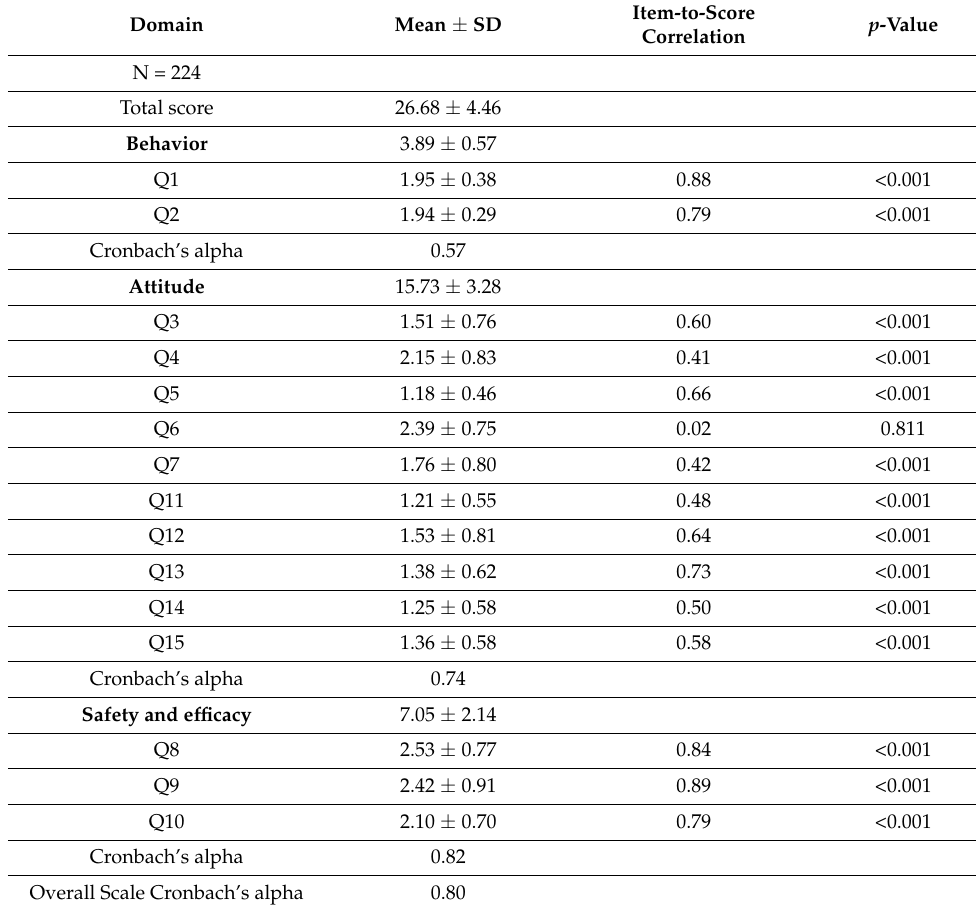
Table 4. Descriptive statistics, reliability, and convergent validity of the Arabic version of the Parent Attitudes About Childhood Vaccines (PACV)